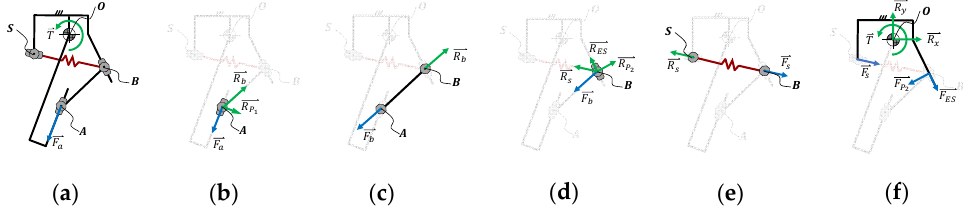
Figure 2. The torque ratio (torque at the output (T) divided by the force at the input (F a )) of the linear implementation is found by performing a free-body diagram analysis of the proposed mechanism ( a ), including the input slider joint ( b ), the connecting bar ( c ), the tuning joint ( d ), the passively actuated joint ( e ), and the output joint ( f ).